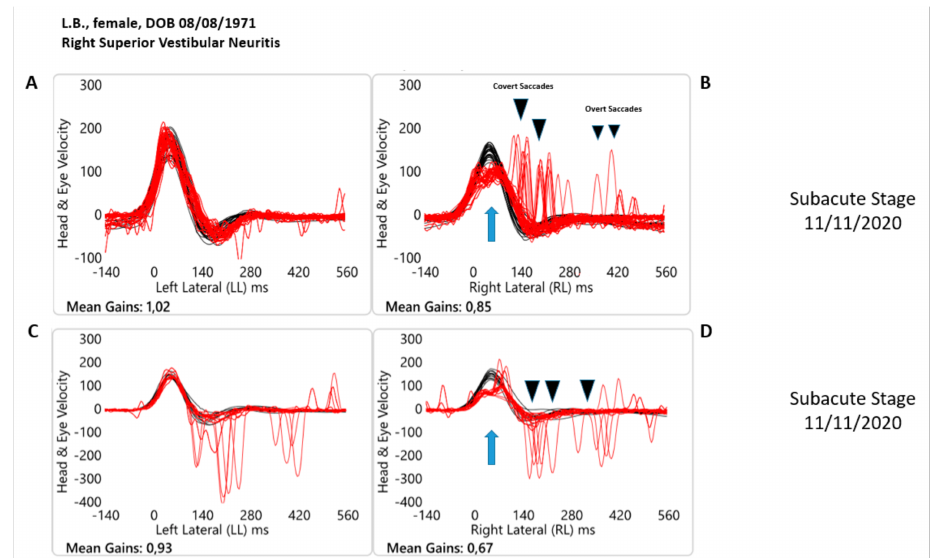
Figure 2. Objective measures of horizontal semicircular canal function at the time at the subacute stage (10 days later the onset of the acute vestibular syndrome) in both paradigm HIMPs ( A , B ) and SHIMPs ( C , D ) with video Head Impulse test Technology for one patient with acute unilateral (right) superior vestibular neuritis. Each panel shows a superimposed time series of head velocity (black for the head impulses) and the corresponding eye velocity (red) for the lateral canal dynamic function. The signs of head velocity for leftward impulses and of eye velocity for rightward impulses have been inverted to allow for easier comparison. Normal horizontal Vestibulo Ocular Reflex (VOR) gains are approximately 0.7–1.0 [4]. Subacute stage ( A , B ) HIMP paradigm. For rotations to the affected side, slow phase eye velocity is back within the limits of the norm but substantially less than the corresponding head velocity during the head turn so the VOR is slightly less, VOR gain is 0.85, then for head turns to the healthy side, VOR gain is 1.02. There is still a shower of compensatory (Covert + Overt) saccades during and at the end of the head turn (black arrow). When the head is turned to the left contralesional side, anti-compensatory saccades (AcS) eye movements in the direction of the head movement have disappeared (see Figure 1, panel A, for comparison). Subacute stage ( C , D ) SHIMP paradigm. In this paradigm for rotations toward the affected side, eye velocity is still substantially less than the corresponding head velocity (red traces vs. black traces). Note how during the head turn, the slow phase eye velocity of the VOR is significantly less also in comparison with the same value in the HIMP paradigm (VOR gain is 0.67). For head turns to the healthy side, VOR gain is the same, 0.93. The blue arrows indicate the reduced angular velocity of the slow phase of the VOR. When the head is turned to the left contralesional, healthy side, anti-compensatory overt SHIMPs saccades at the end of the head turn (black arrow, C ) eye movements in the direction of the head movement can be observed. In sharp contrast with the acute stage, on this occasion, when the head is turned toward the right affected side, note how anti-compensatory SHIMPs saccades have